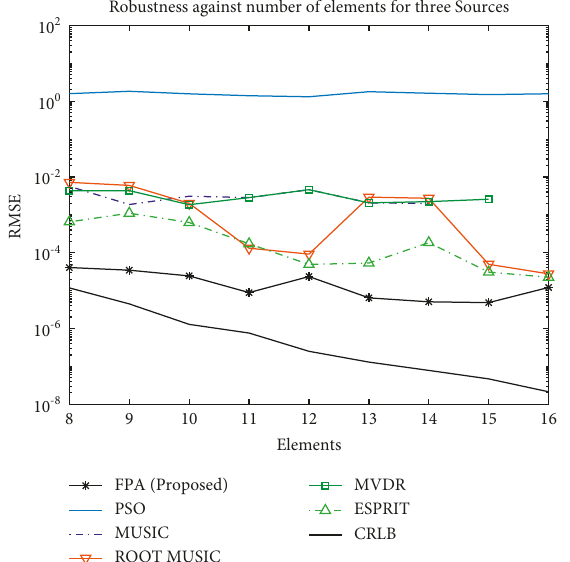
Figure 13: Robustness against snapshots for two